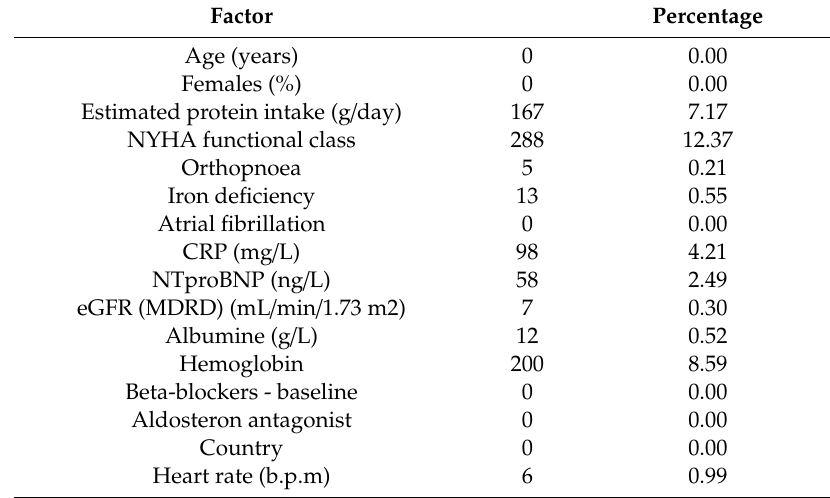
Table A1. Selected variables that entered the analysis and their degree of missingness.